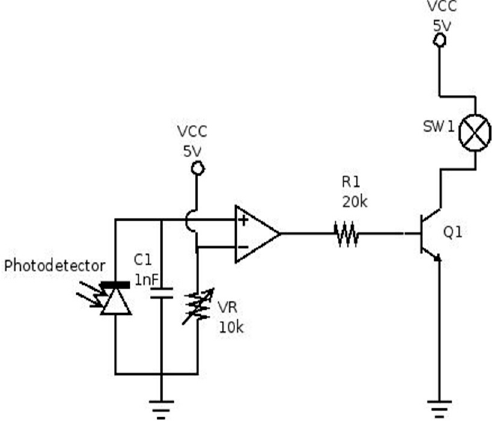
Figure 6. Detection circuit.